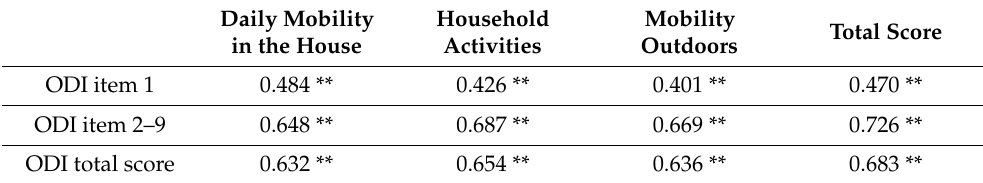
Table 3. Pearson’s correlation scores comparing the PMI with the ODI scale. ** p <